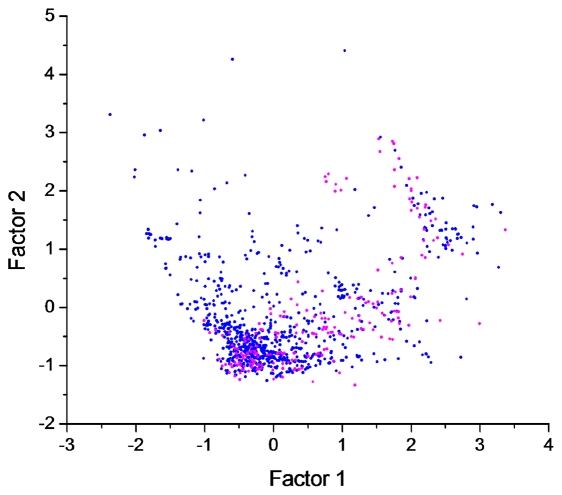
Chemical space of anaerobic metabolites defined by the first two factors from an analysis of 20 descriptors, showing early anaerobic metabolites (in magenta) preferentially occupying the right and lower parts of the space.